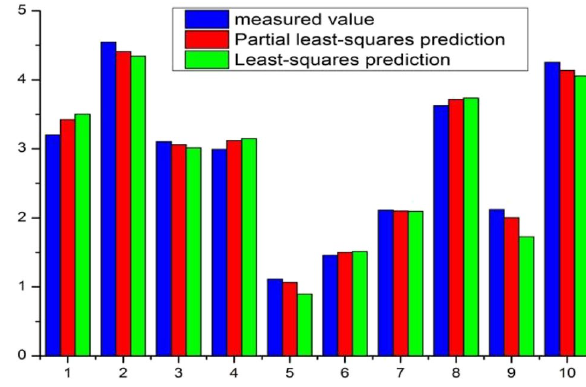
Fig. 11 The variables important in projection